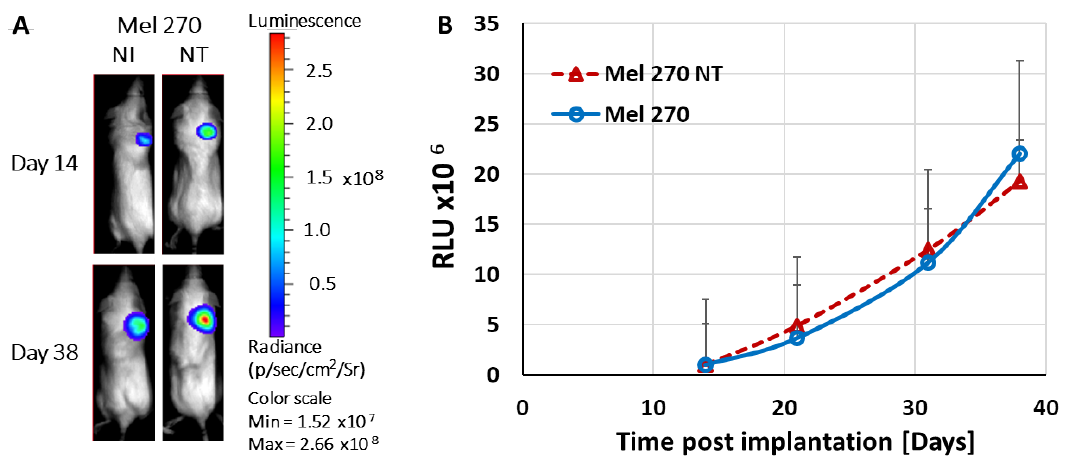
Figure 4. Kinetics of tumor growth. Not infected (NI) Mel270 and Mel270-stably infected with vACE-NT (Mel270 NT) stably expressing the luc gene were injected subcutaneously in SCID mice ( n = 5 in each group). Growth of tumors was monitored over 38 days via bioluminescence while using the IVIS camera, as previously described [14] . ( A ) Pictures of one representative mouse per group; ( B ) Tumor growth rate expressed by relative light units (RLU).